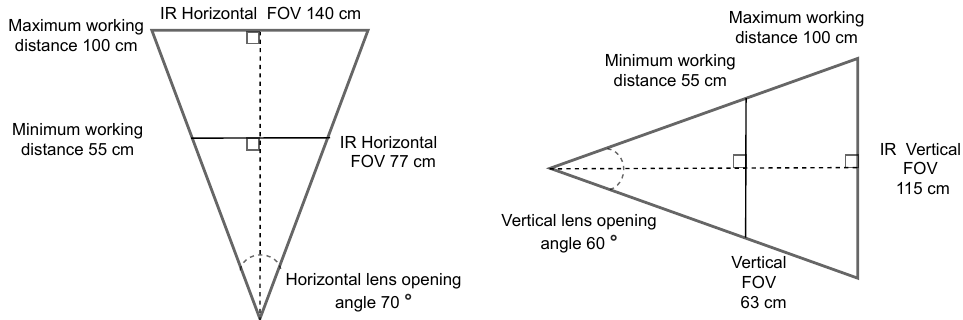
Figure 2. The horizontal and vertical field of view were calculated based on the Kinect V2’s lens opening angles, using 100 cm as a reference maximum working distance for the imaging